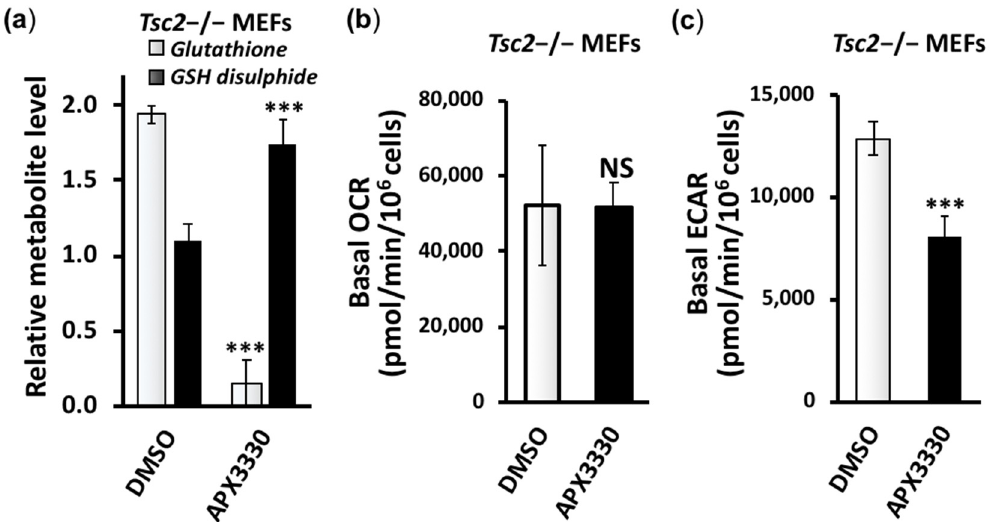
Figure 6. APX3330 treatment affects glutathione homeostasis and ECAR but not OCR. ( a ) The levels of glutathione and glutathione disulfide in the untreated and 25 µ M APX3330-treated Tsc2 − / − MEFs are graphed. ( b ) Basal oxygen consumption rate (OCR) and ( c ) extracellular acidification rate (ECAR) assessed in Tsc2 − / − MEFs after 18 h treatment of 25 µ M APX3330 in 10% ( v / v ) FBS compared to DMSO. Error bars represent SDs; *** p < 0.001 when compared to their paired DMSO control.